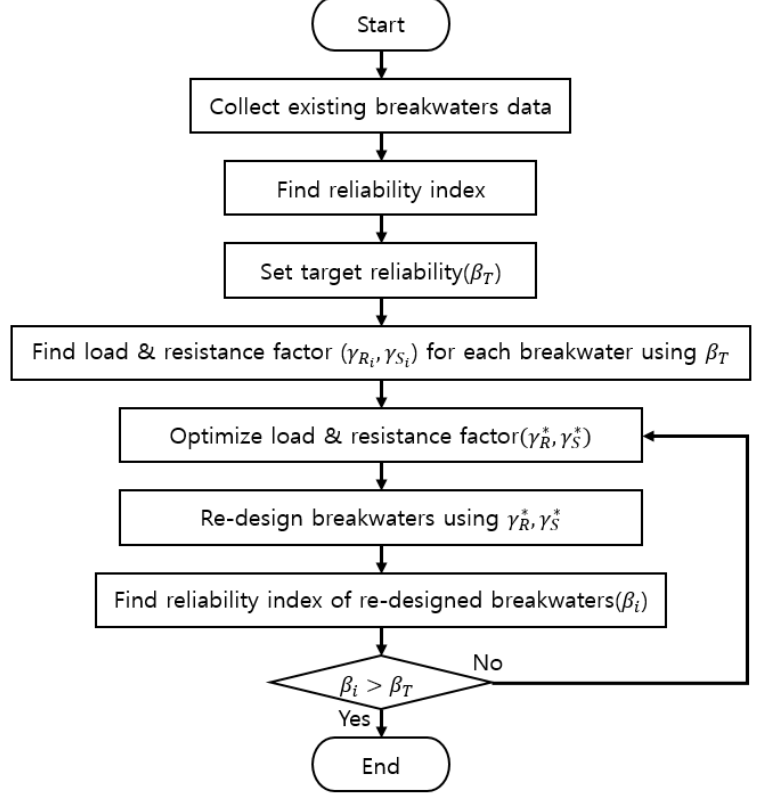
Figure 2. Flowchart for code calibration of